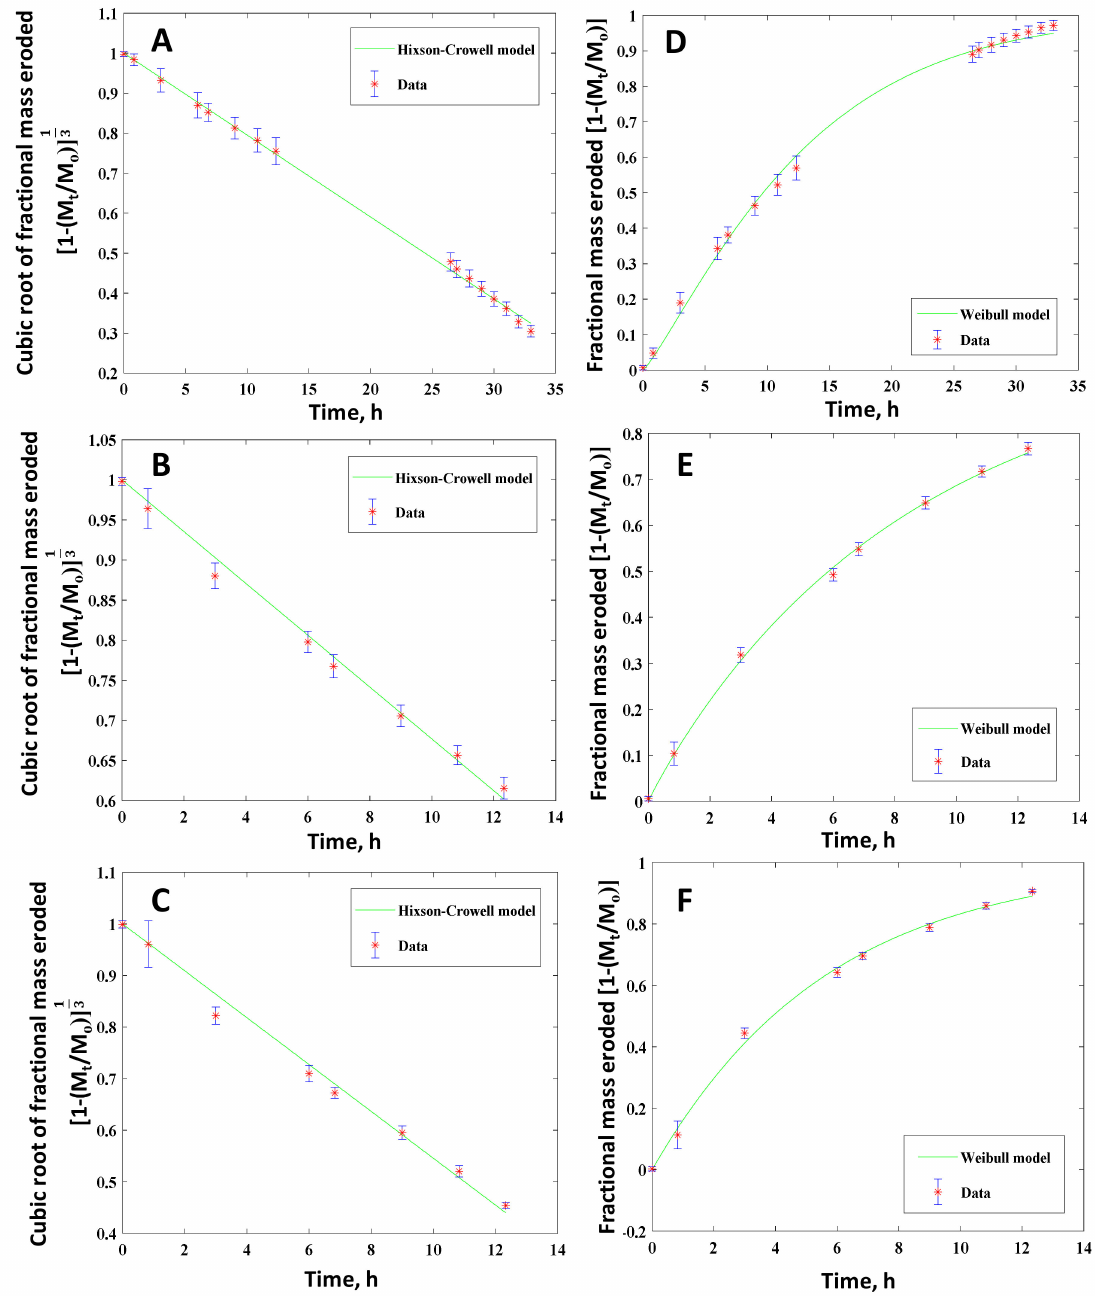
Figure 10. Fractional mass eroded as a function of time for cuboid PAH tablets with di ff erent crosslinking ratios in PNA:PETMP:EGDT systems. Mole ratios of 100:100:0 ( A , D ), 100:75:25 ( B , E ) and 100:50:50 ( C , F ). Best fitted kinetic models with red dots (experimental data) and green lines are the fitted curves for Hixson-Crowell ( A – C ) and Weibull ( D – F ) release kinetic models. Hixson-Crowell kinetic model, as one of the best-fitted models, is developed for erosion